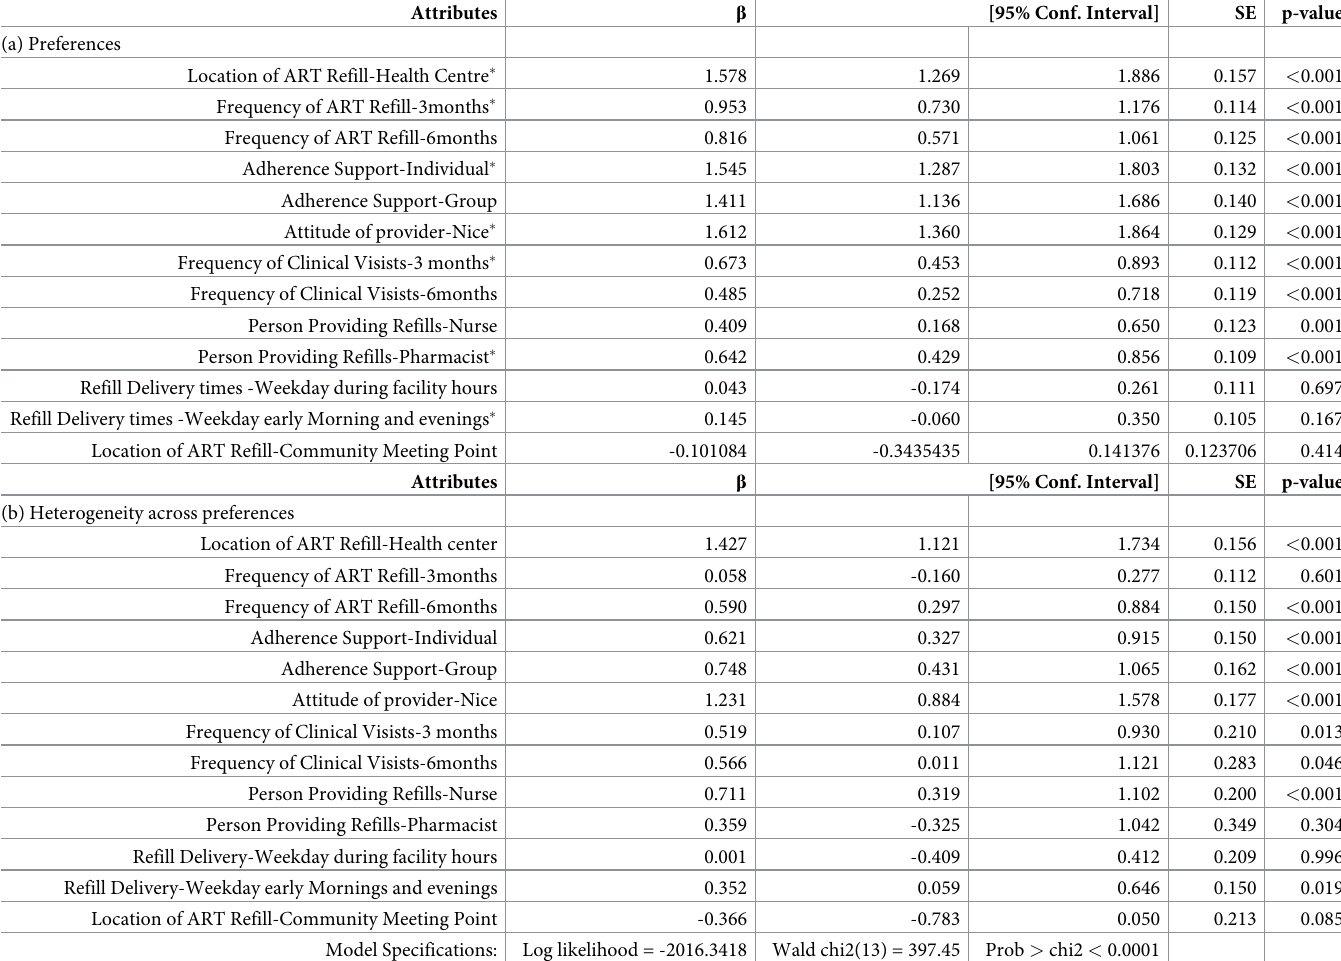
Table 4. Mixed Logit Model—(a) Preferences and (b) Heterogeneity of Preferences for Differentiated Service Delivery Attributes. Attributes β [95% Conf. Interval] SE p-value